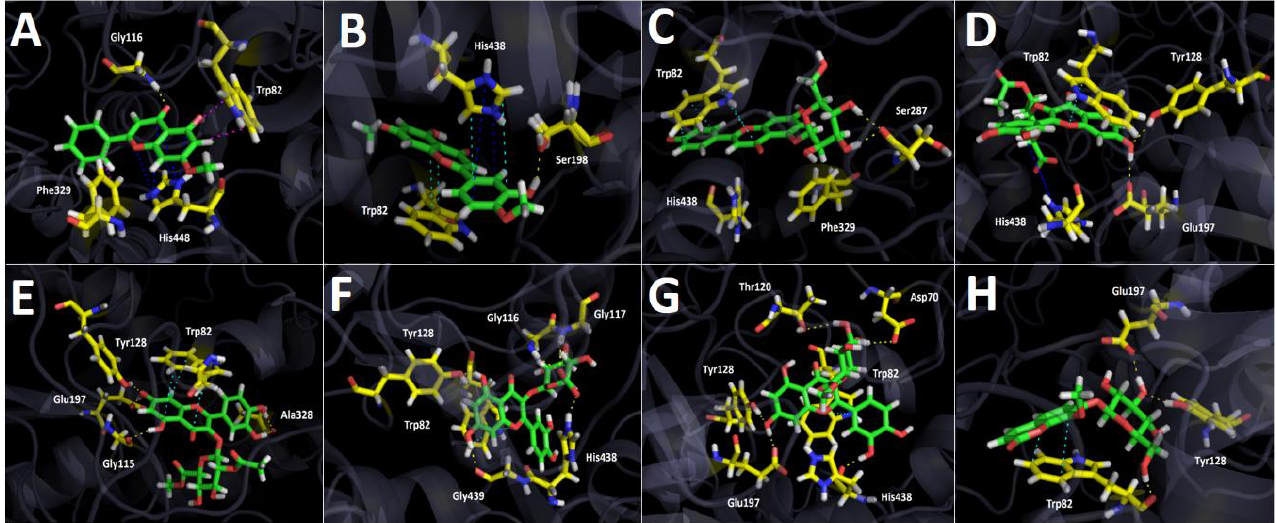
Figure 6. Predicted binding mode and predicted intermolecular interactions of most abundant compounds in Ovidia pillopillo leaves extract and the residues of Torpedo Californica acetylcholinesterase ( Tc AChE) catalytic site. Yellow dotted lines indicates hydrogen bond interactions, cyan dotted lines represents π - π interactions, magenta dotted lines represents T-shaped interactions, blue dotted lines represents π -cation interactions. ( A ). 5-hydroxy-7-methoxy-2-phenyl-4 H -chromen-4-one into the catalytic site; ( B ). Luteolin 7, 4′ -dimethyl ether into the catalytic site; ( C ). Apigenin 5-glucoside into the catalytic site; ( D ). Quercetin 3-O-ß -D-2 ″ -acetylglucuronide into the catalytic site; ( E ). Quercetin 3-O-ß-D-2 ″ -acetylglucuronide methyl ester into the catalytic site; ( F ). Quercetin 3-O-(ß-D-glucuronide) into the catalytic site; ( G ). Quercetin 3-O-ß -D-(glucuronide methyl ester) into the catalytic site; ( H ). 8-O-metyl daphnin, (daphnetin 7 O-glucose, 8-methyl ether) into the catalytic site.